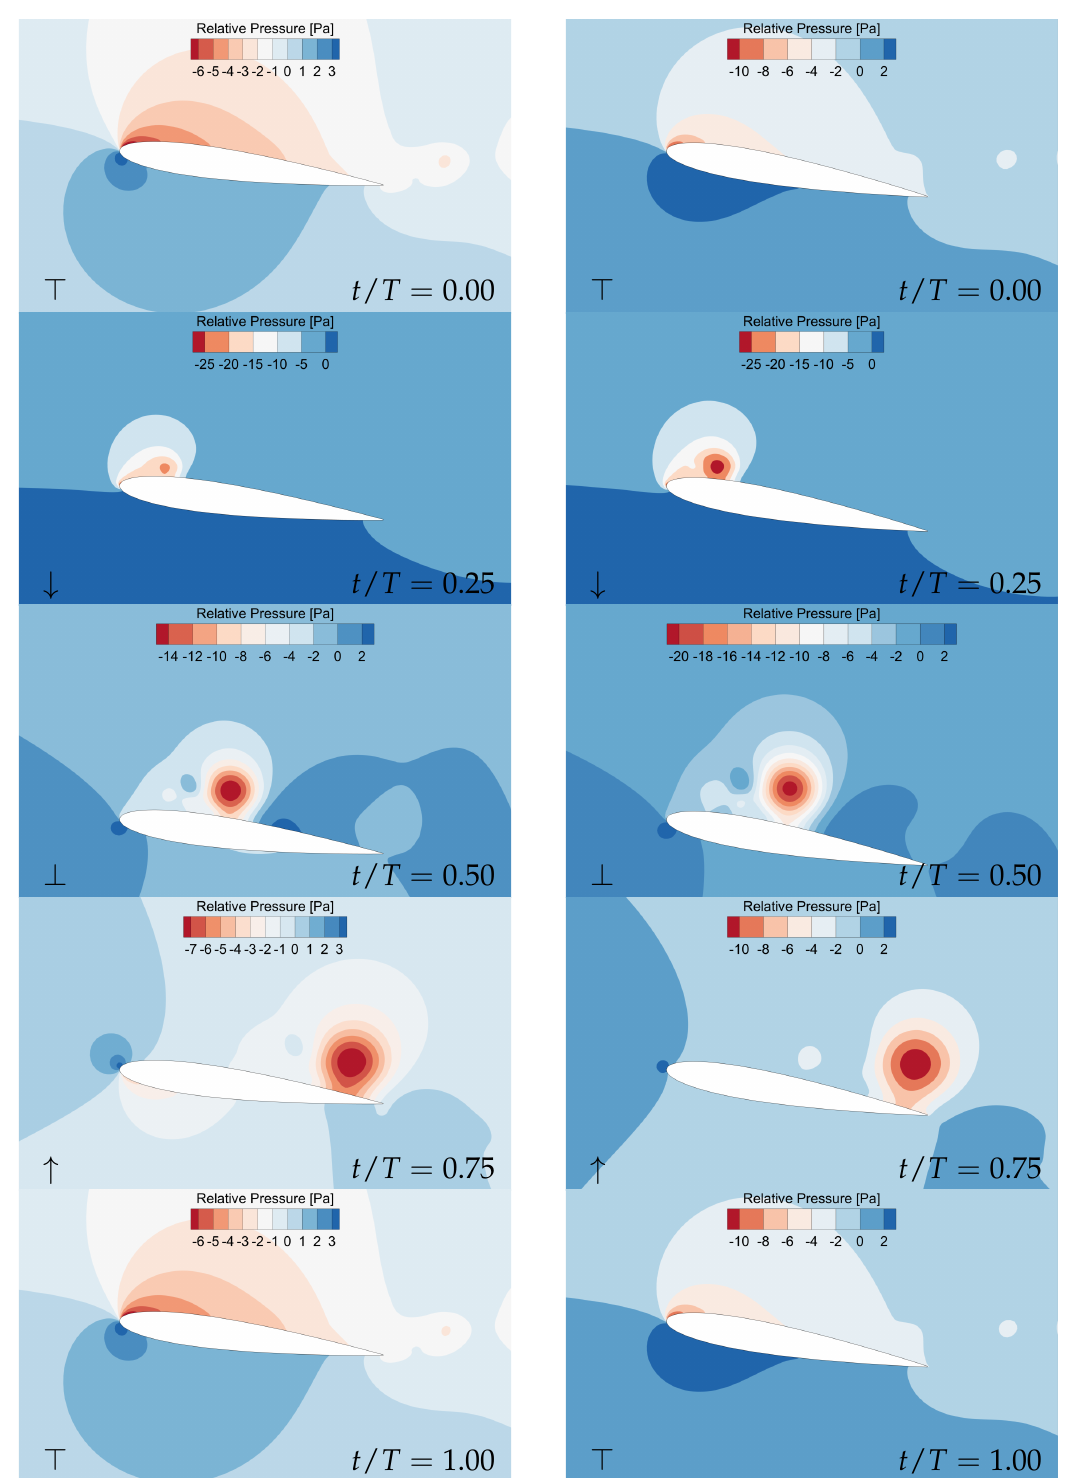
10 4 , k = 2.0 and h = 0.157 with α 0 = 7.5 ◦ (left) and ×